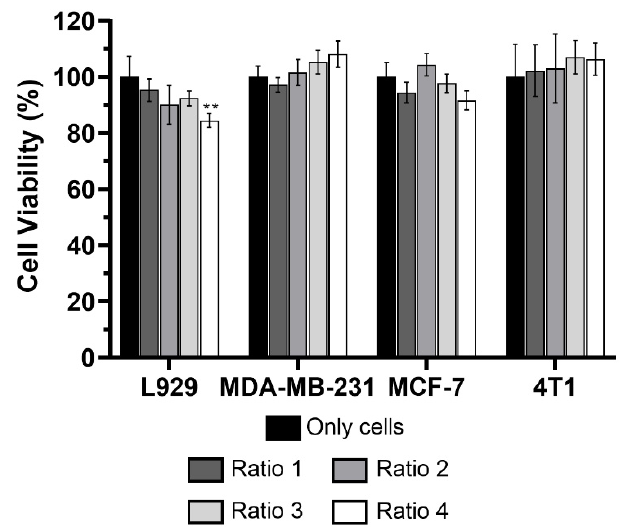
Figure 12. Cell viability (%) of L929, MDA-MB-231, MCF-7 and 4T1 cells incubated for 24 h in complete medium (black columns) and with different types of AuNPs (Ratio 1, Ratio 2, Ratio 3 and Ratio 4 AuNPs) at a concentration of 128 ± 21 µM in terms of Au content. The results represent the mean value ± SD, n ≥ 5. Statistical significance represents: ** p < 0.01 compared with the cells from the same line incubated in complete medium, which represent 100% viability.